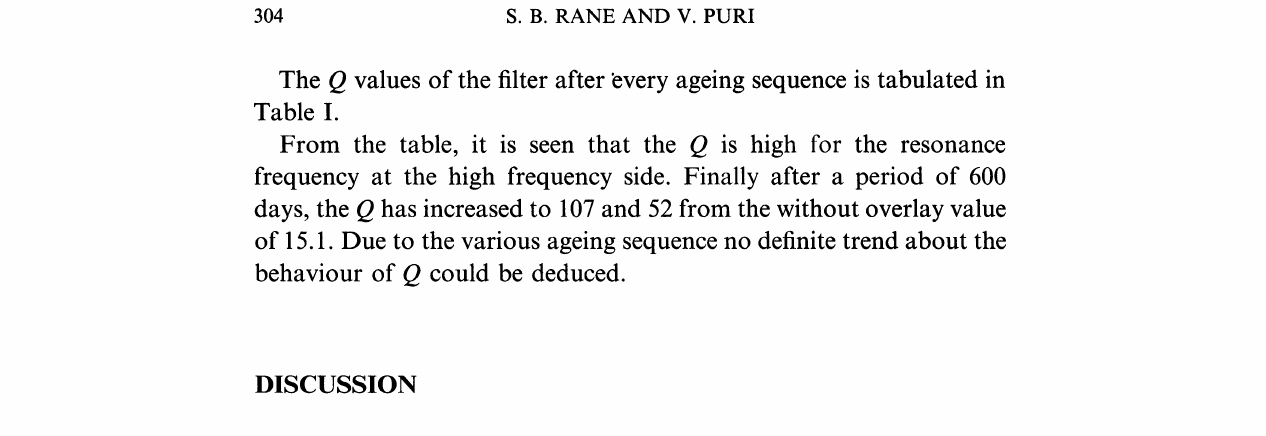
Data of quality factor